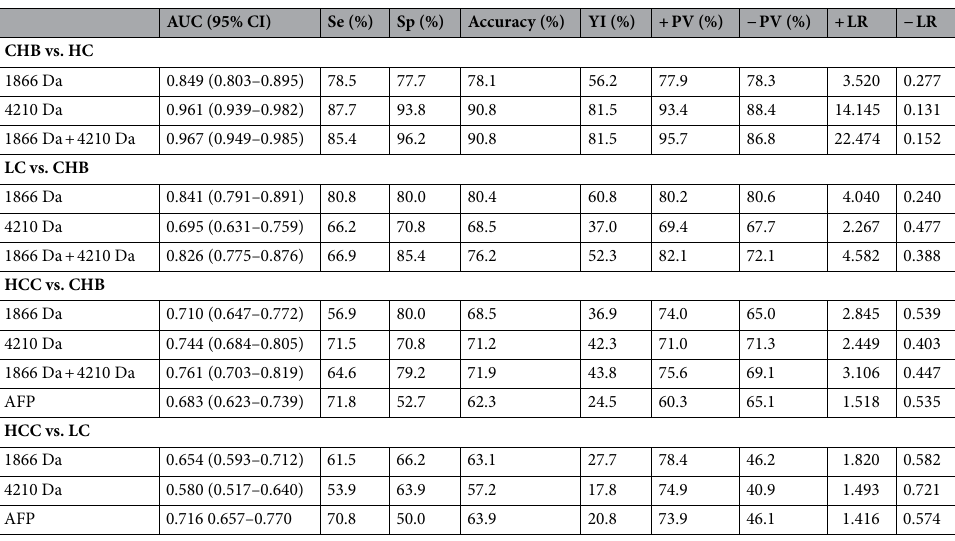
Table 2. Evaluation indexes of the diagnostic effectiveness of 1866 Da, 4210 Da and AFP. AUC area under the curve, Se sensitivity, Sp specificity, YI Youden index, + PV positive predictive value, − PV negative predictive value, + LR positive likelihood ratio, − LR negative likelihood